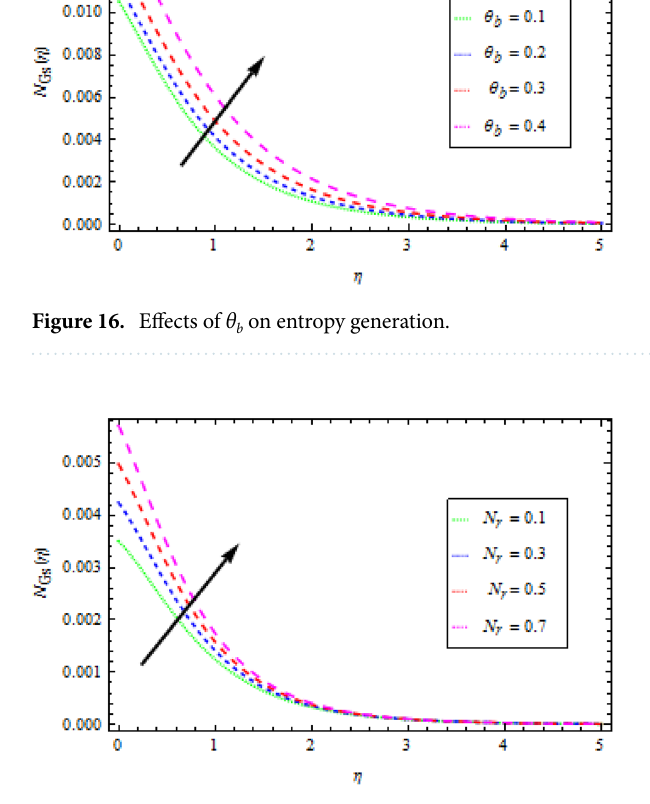
Figure 17. Effects of N r on entropy generation.